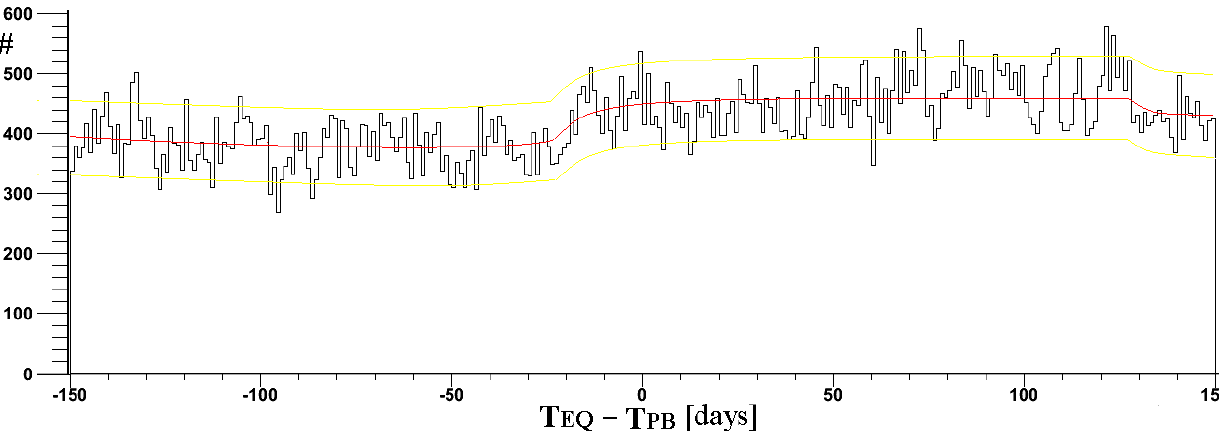
Figure 8. If PB electrons in the energy range of 30–100 keV were compared with M ≥ 6.2 EQ epicenters projected to 800 km, a step correlation appears which has a seasonal time length. The red line represents the average while the yellow lines represent ±3 sigmas from the average. Distributions binning was of one